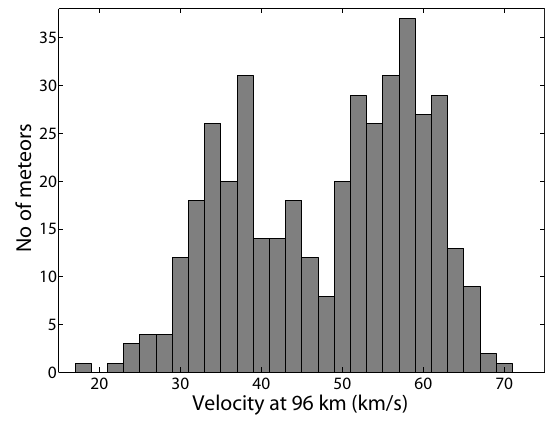
Fig. 6. Distribution of observed velocities.